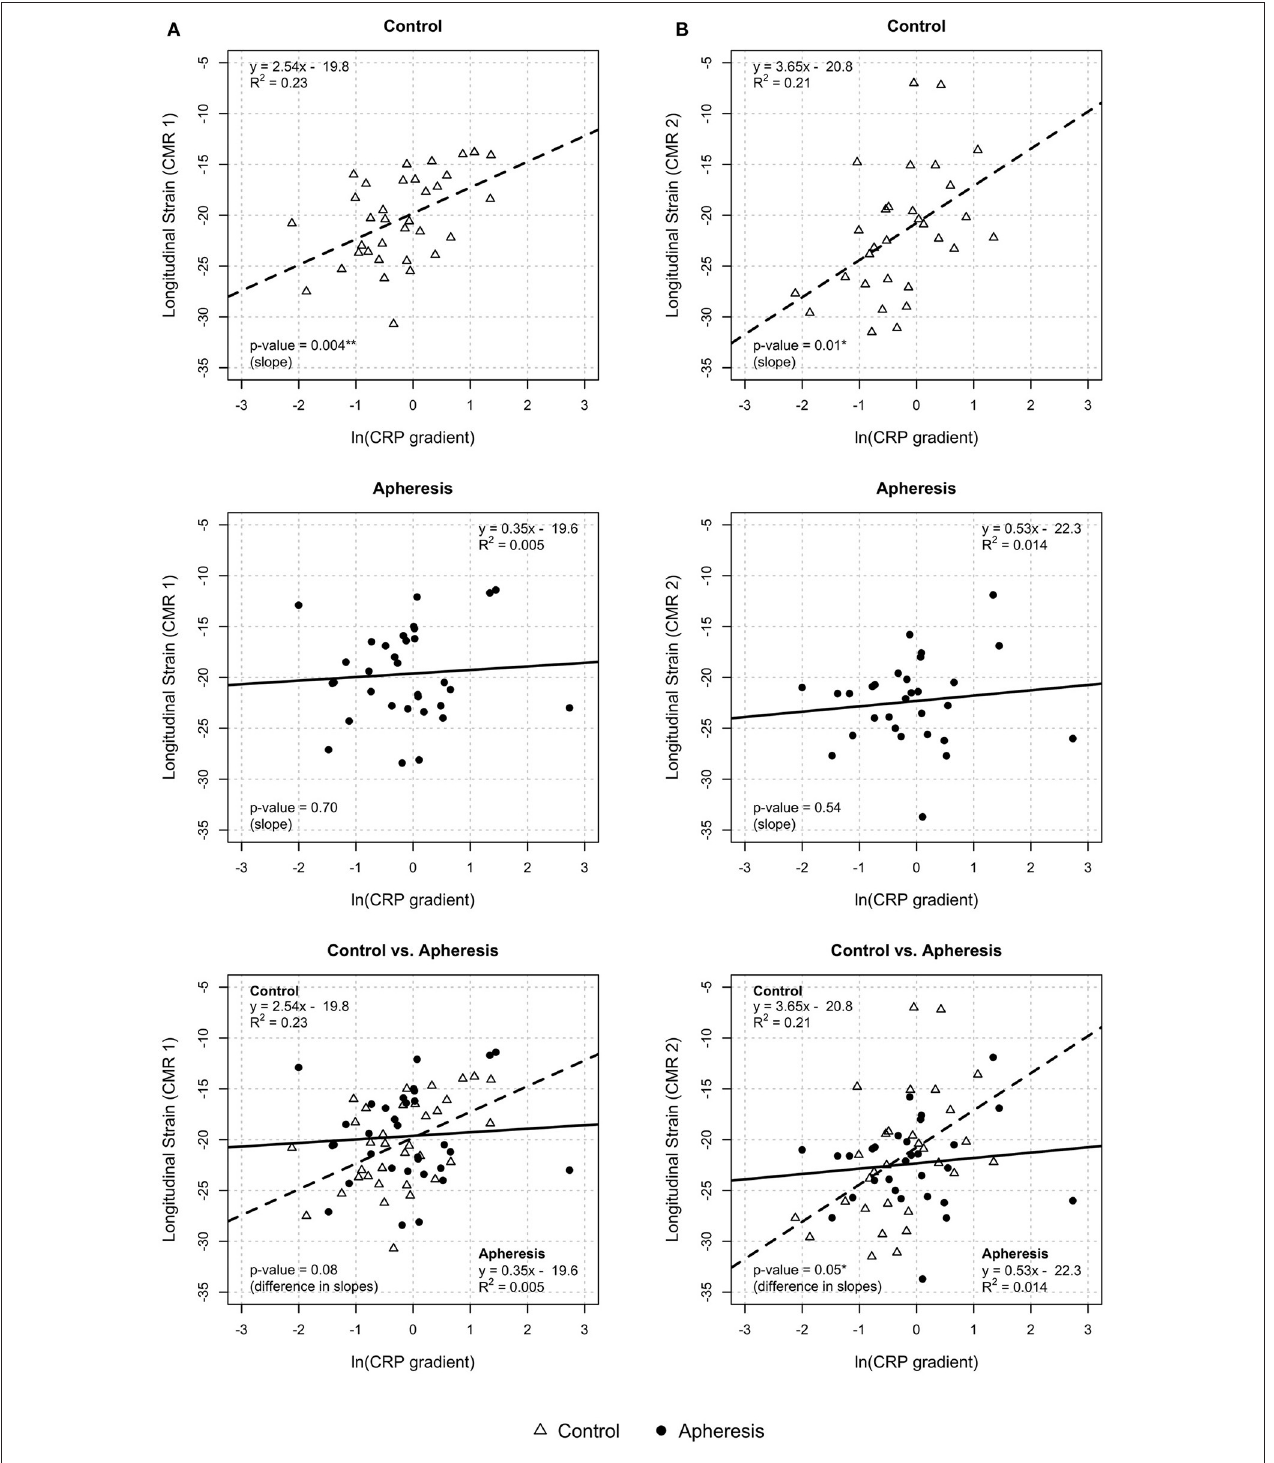
FIGURE 6 | Longitudinal strain CRP gradient [ln(CRP gradient)] at CMR1 (A) and CMR2 (B) . CMR1—control group: Highly significant increase of longitudinal strain with increasing values of CRP gradient ( p = 0.004) and increase of ln(CRP gradient) by 1 unit results in an increase of longitudinal strain by about 2.5 units. Apheresis group: Small increase of longitudinal strain with increase of CRP gradient ( p = 0.7). Here, there is no statistically significant difference between groups ( p = 0.08). CMR2—control group: significant increase of longitudinal strain with increasing values of CRP gradient ( p = 0.01). Increase of ln(CRP gradient) by 1 unit results in an increase of longitudinal strain by about 3.6 units. Apheresis group: Small increase of longitudinal strain with increase of CRP gradient ( p = 0.54). There is a statistically significant difference between groups ( p = 0.05).